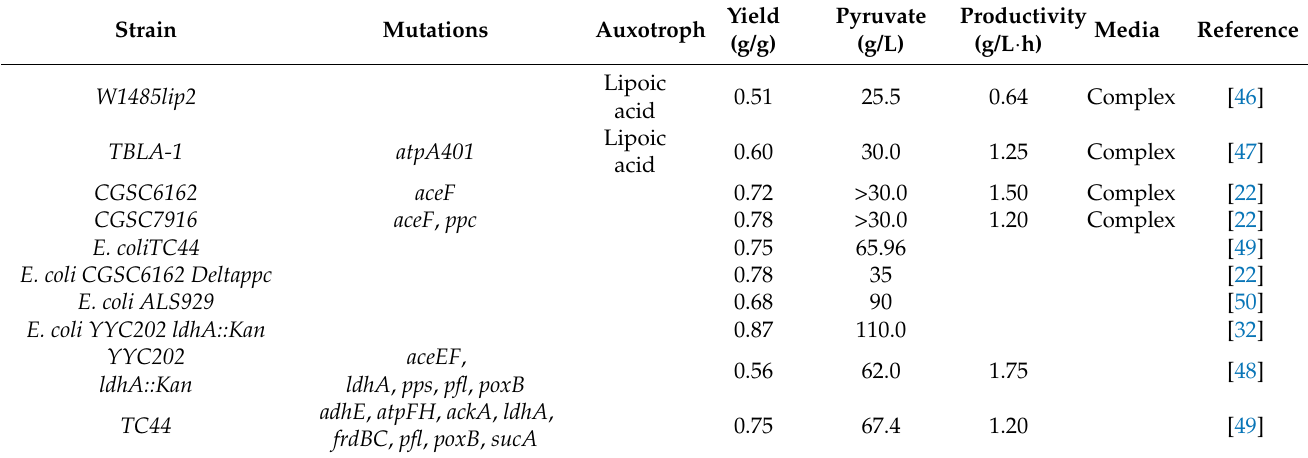
Table 1. Recombinant E. coli strains used for the production of